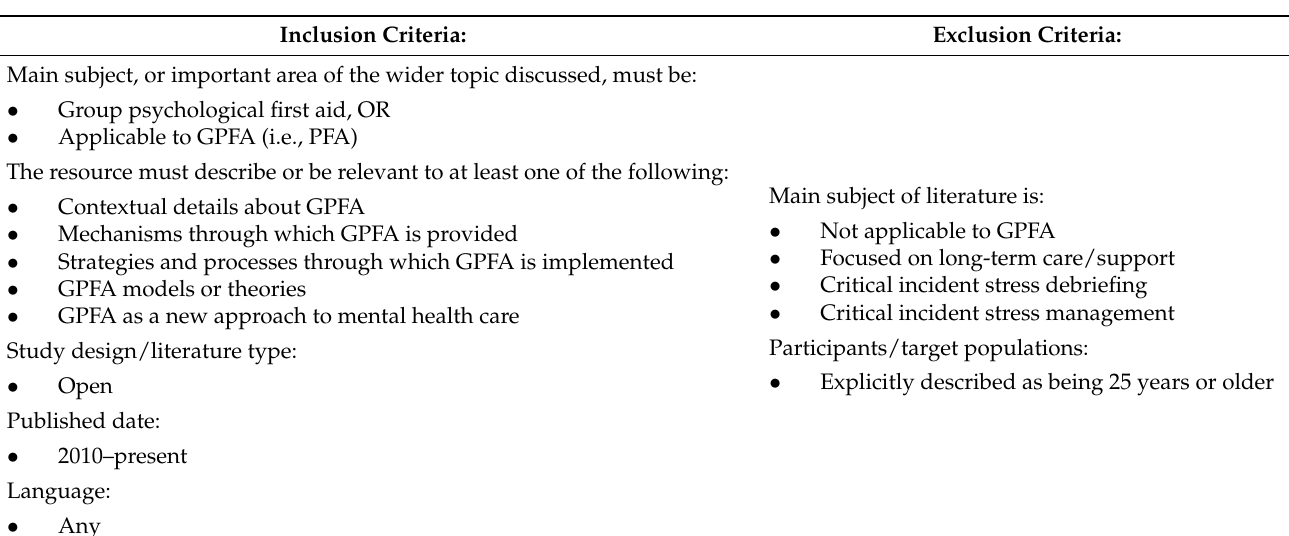
Table 3. Inclusion/exclusion